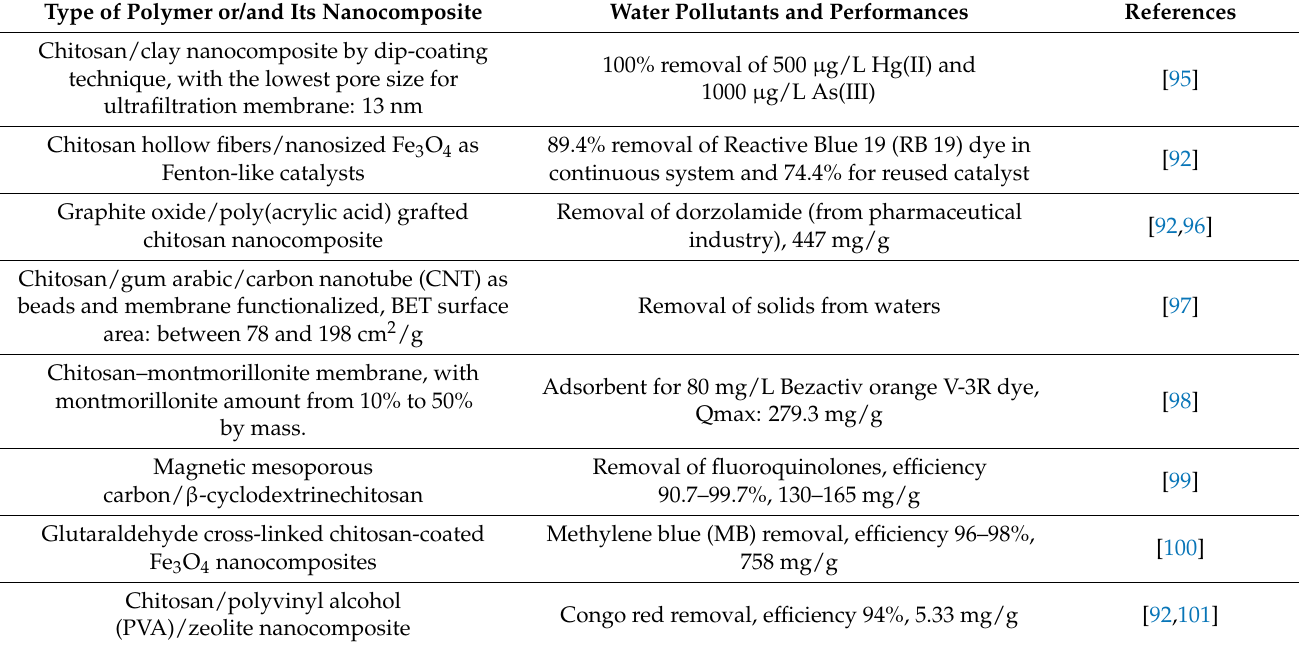
Table 2. Natural polymers and their nanocomposites used for water pollutant